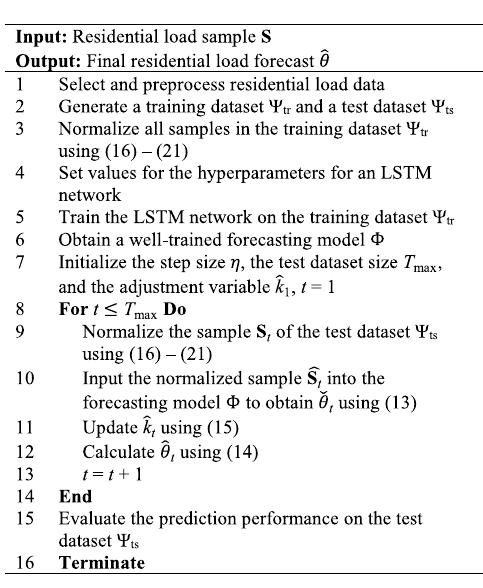
Algorithm 2: LSTM and DMD Integration for Adaptive Individual Residential Load Forecasting